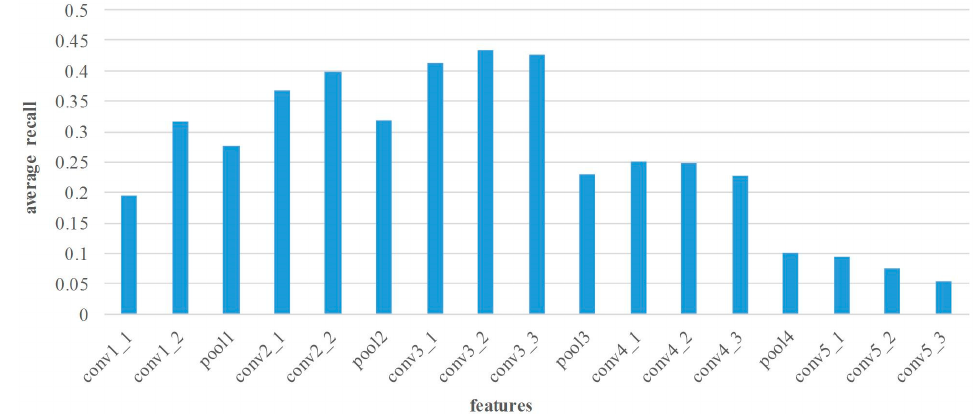
Figure 6. Average matching recall comparison of various layers’ features on Middlebury dataset. The horizontal axis denotes the various layers’ features, and the vertical axis is the average matching recall.